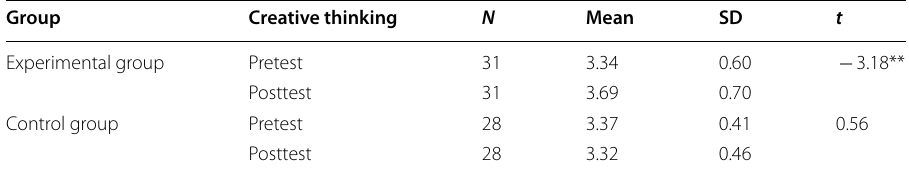
Table 3 Paired‑sample t test between the pre‑ and posttests of creative thinking for the experimental and control groups